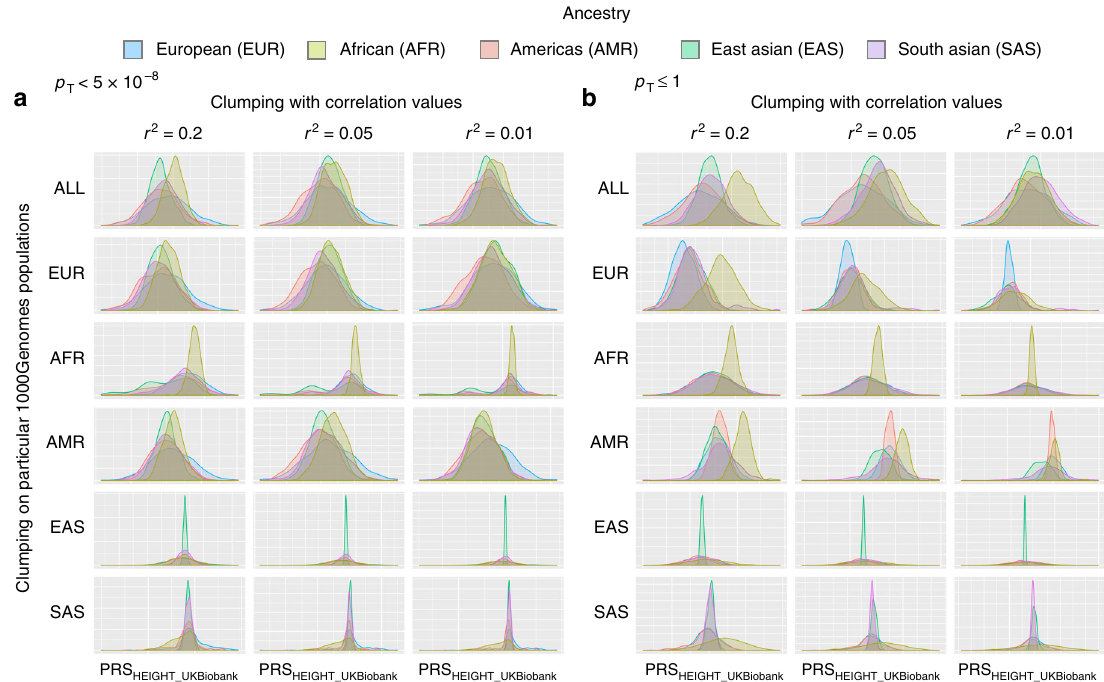
Fig. 3 Polygenic score distributions vary by ancestry and methodical choices. For polygenic score construction, clumping is often used, and investigator- driven choices can produce large differences in score distributions for global populations. Polygenic score distributions for the fi ve major 1000Genomes populations are plotted, showing how investigator-driven choices impact score distributions. For all plots, weights were derived from the UK biobank height GWAS. Both r 2 values used in clumping ( r 2 = .2, .05, .01; see columns) and 1000Genomes populations used for clumping were varied (ALL, EUR, AFR, AMR, EAS, SAS; see rows). a , b correspond to the p -value threshold ( p T ) applied to the height summary statistics. a p T = genome-wide signi fi cant variants ( p < 5 × 10 − 8 ); b p T = full genome variants ( p < 1). PRS = polygenic risk score. ALL union of fi ve 1000Genomes